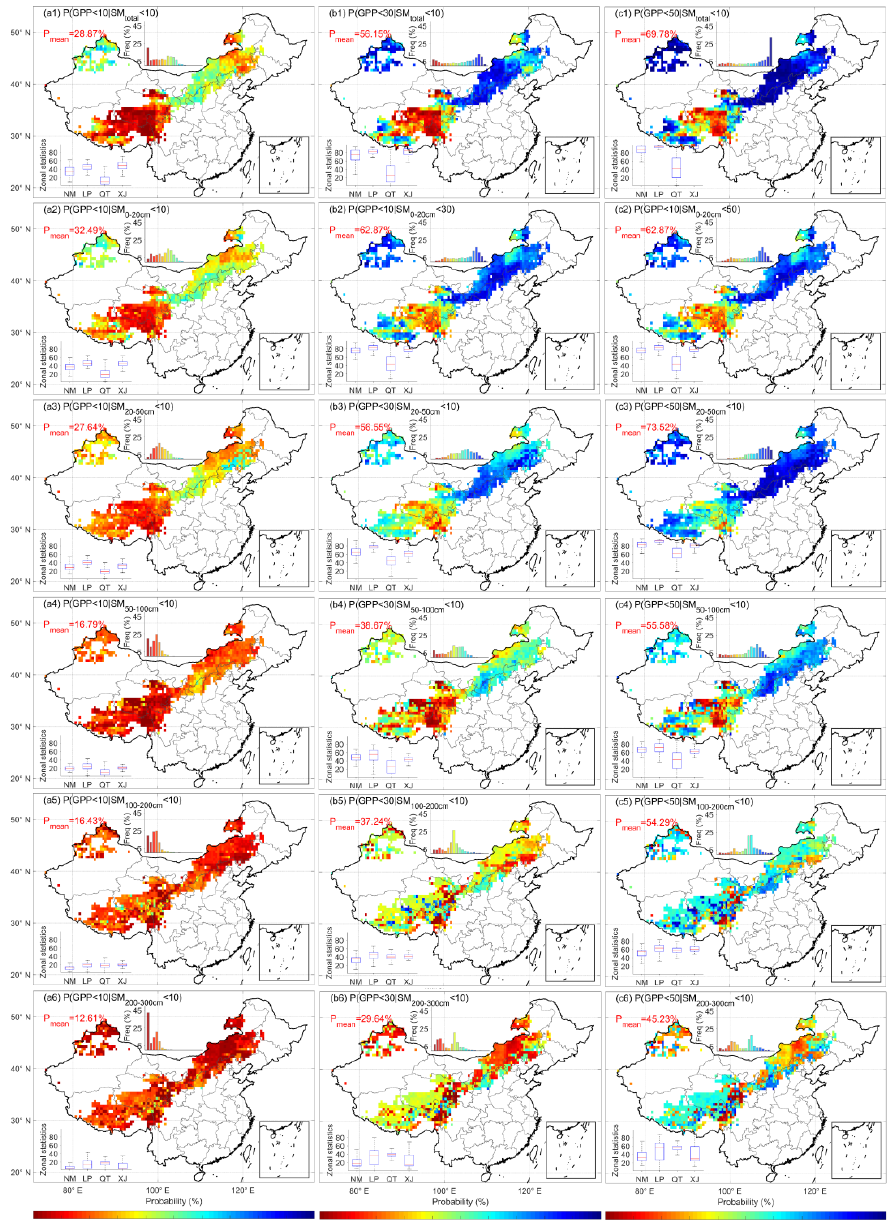
Figure 5. Conditional probabilities of ecosystem GPP loss under severe soil drought conditions (i.e., probability when soil moisture is below 10% threshold in the 1901 – 2005 time series) at different soil depths of Chinese grasslands during the historical period. ( a – c ) The probability of severe ecosystem GPP loss under severe soil drought conditions; 1 – 6 represent the soil depths of 0 – 300 mm, 0 – 20 mm, 20 – 50 mm, 50 – 100 mm, 100 – 200 mm, and 200 – 300 mm, respectively. The regional average trend values are counted as box plots in the lower left corner. NM, LP, QT, and XJ represent grasslands in Inner Mongolia, the Loess Plateau, the Tibetan Plateau, and Xinjiang, respectively, and red dots represent anomalies. The histogram is the frequency statistics.